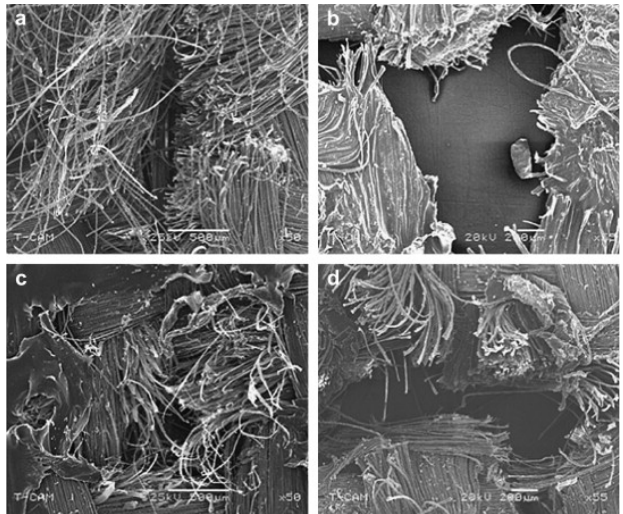
Figure 7. Scanning electron micrographs of ( a ) pure Kevlar, ( b ) PE composite, ( c ) Surlyn/PE composite, and ( d ) Surlyn composite after dynamic stab testing. Reprinted from [58], Copyright (2009), with permission from Elsevier.